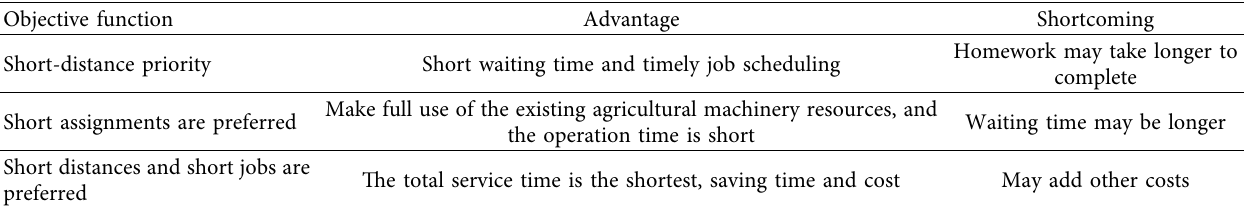
Table 1: Comparison of objective